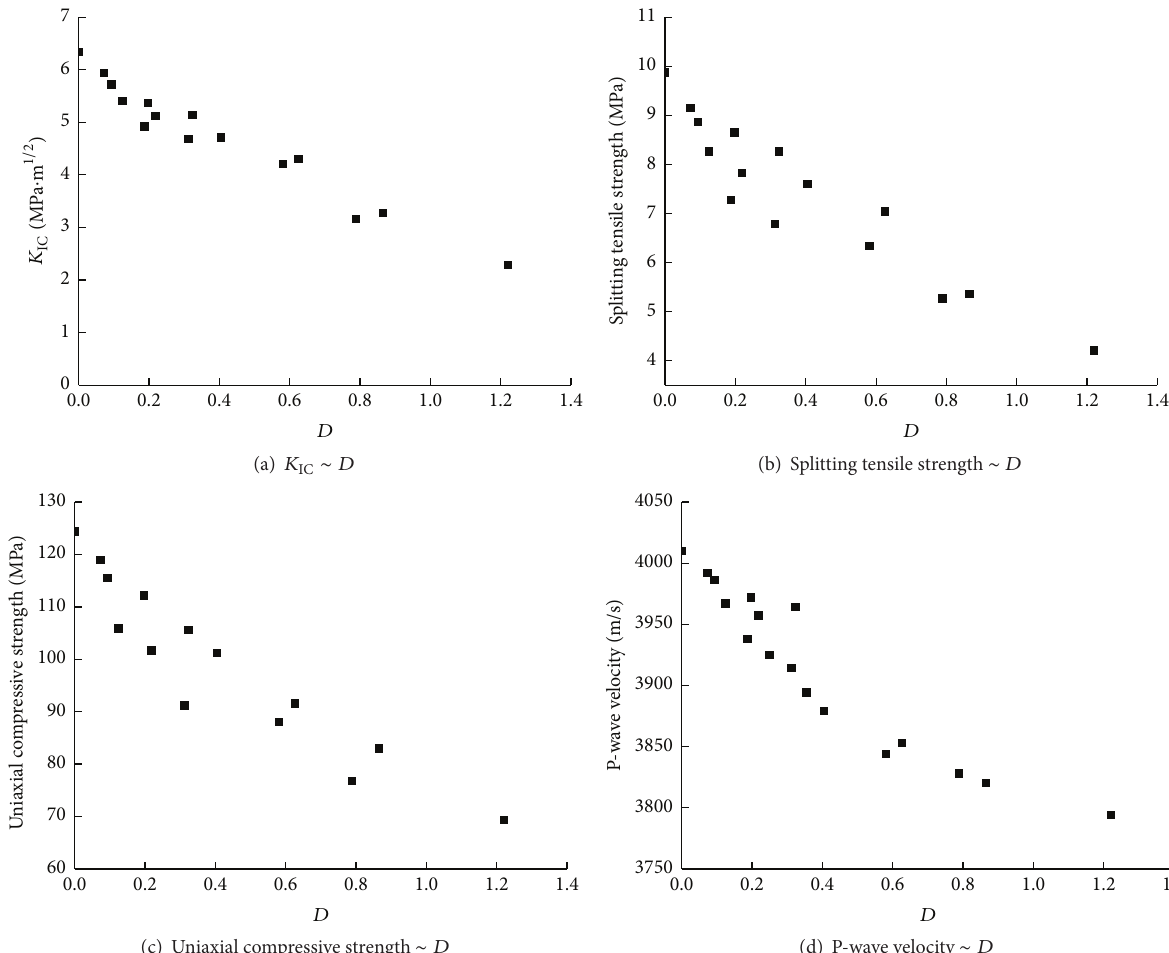
Figure 10: Relationship between physical and mechanical parameters and damage variable of marble